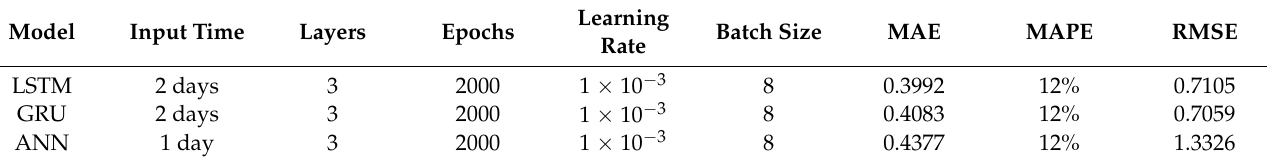
Table 6. The hyperparameter tuning results of LWS historical data.